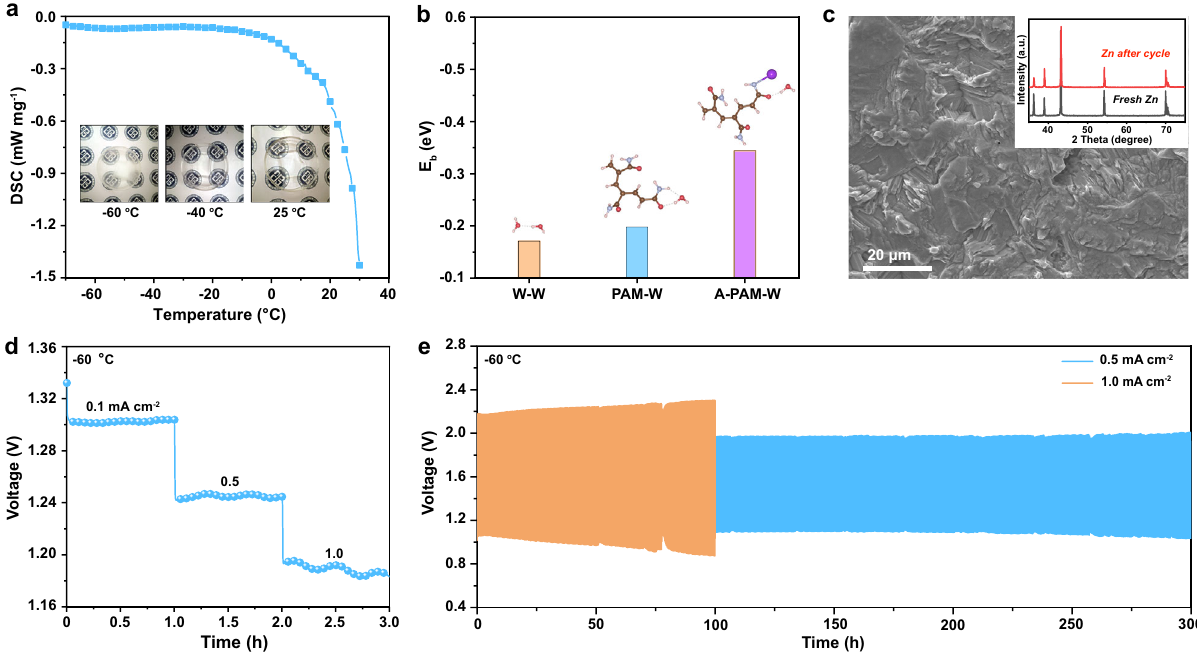
Fig. 4 Characterizations of the organohydrogel electrolyte and electrochemical performance of the Co SA-NDGs-based quasi-sold-state ZABs at − 60 °C. a DSC curve of the PAM organohydrogel electrolyte. Inset shows the corresponding photographs recoded at 25, − 40, and − 60 °C. b The E W-W, PAM-W, and A-PAM-W. The purple, brown, lavender, red, and pink balls refer to K, C, N, O, and H atoms, respectively. c SEM image of Zn plate after 500 h cycling test of symmetric Zn | |Zn cell at 0.5 mA cm − 2 and − 60 °C. Inset shows the corresponding XRD patterns. d Rate performance of the Co SA-NDGs-based quasi-solid-state ZABs at − 60 °C. e Charging/discharging cycling performance of quasi-solid-state ZABs with Co SA-NDGs at different current densities at − 60